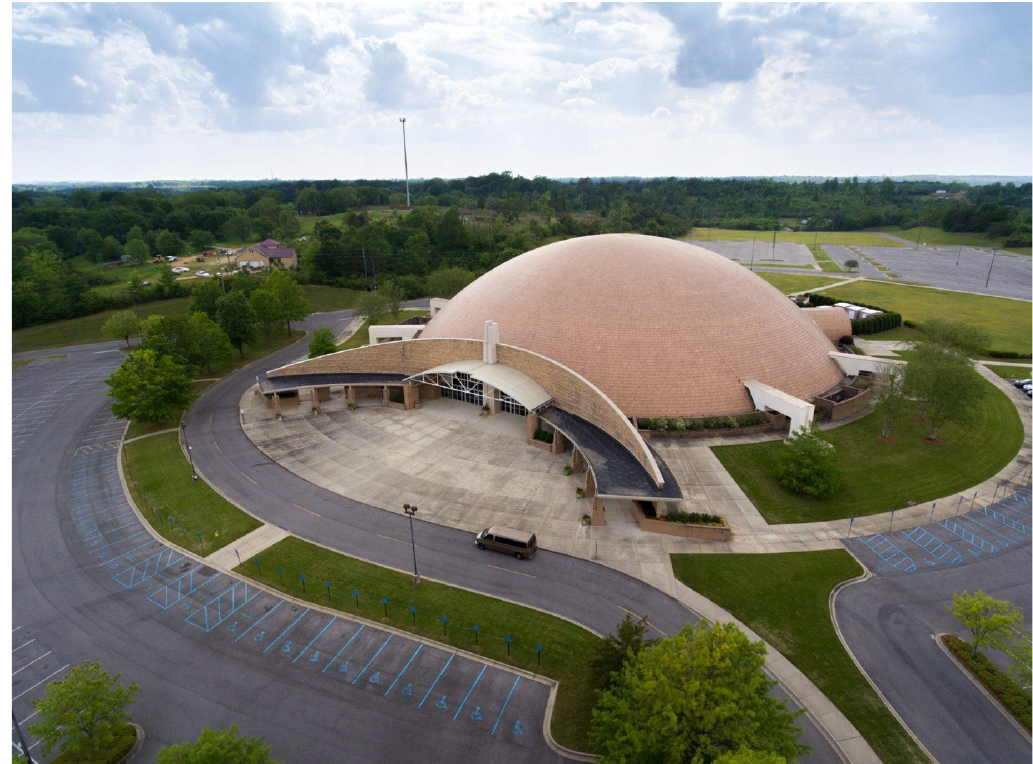
Figure 7. 73‐fthigh dome atFaithChapel in Birmingham, Alabama, completed in December 2002. Source: Dome Technology